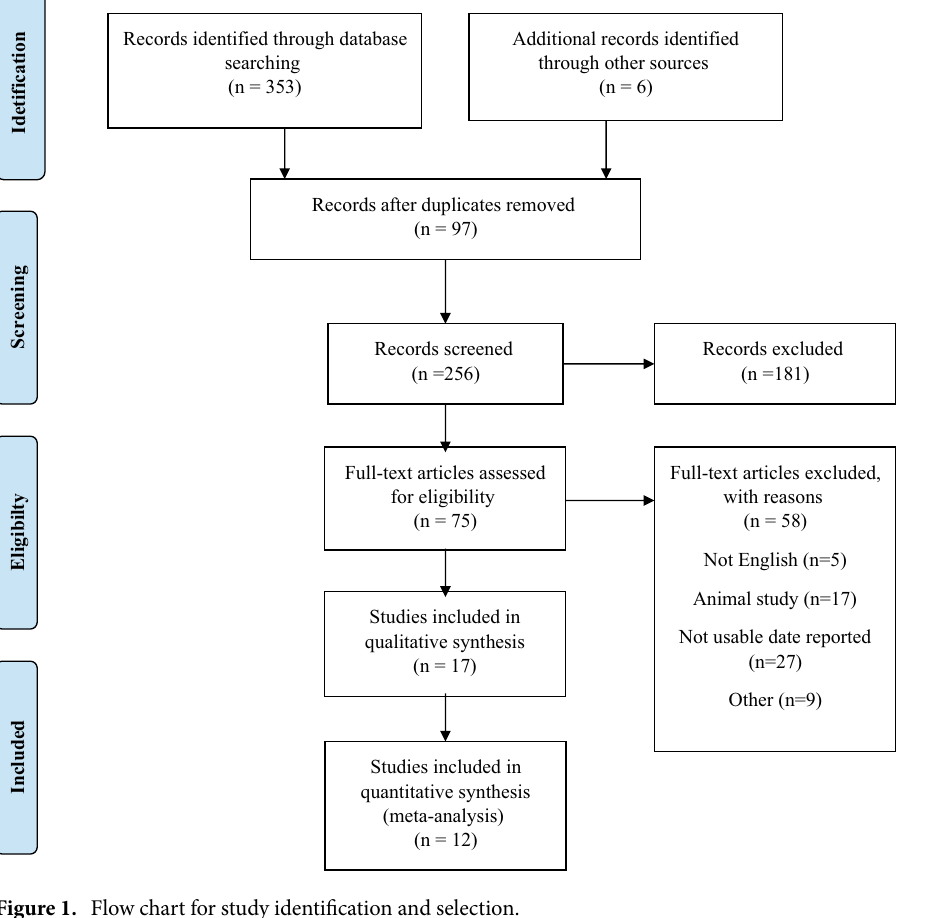
Figure 1. Flow chart for study identification and